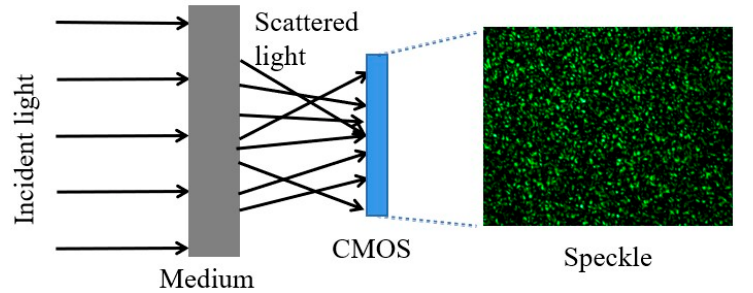
Figure 1. Principle of scatter imaging.